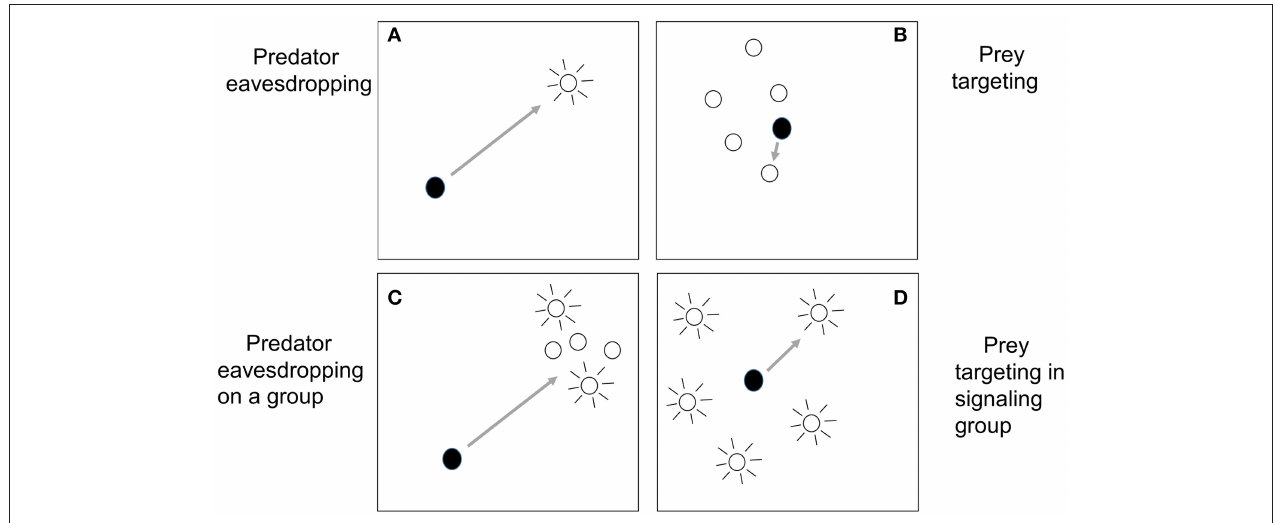
FIGURE 1 | How the simplest cases of predator eavesdropping (A) differ from prey targeting (B) is clear. In predator eavesdropping, a distant predator detects a signaling prey, and subsequently approaches, whereas in prey targeting, the predator has already detected a tight group of prey, is close to it, and now selects one individual to attack. However, other situations may be more of a blend of both processes. In (C) , predator eavesdropping on a group, a distant predator approaches a group as a whole after detecting the signaling of some of its members. Hence, the signaling of some group members influences the predation risk of others; see section Signaling in Mixed-Species Groups and Aggregations for a discussion of this situation. In (D) , prey targeting in a signaling group, the predator is close to or inside a group in which multiple individuals are signaling. In the widely dispersed group shown in this panel, the predator must travel a long distance to attack one prey, close to the distances traveled in predator eavesdropping. In section The Cocktail Party Effect: Is There an Auditory Analog of the Confusion Effect?, we ask if a situation such as (D) might result in a confusion effect, as occurs in the simpler case of prey